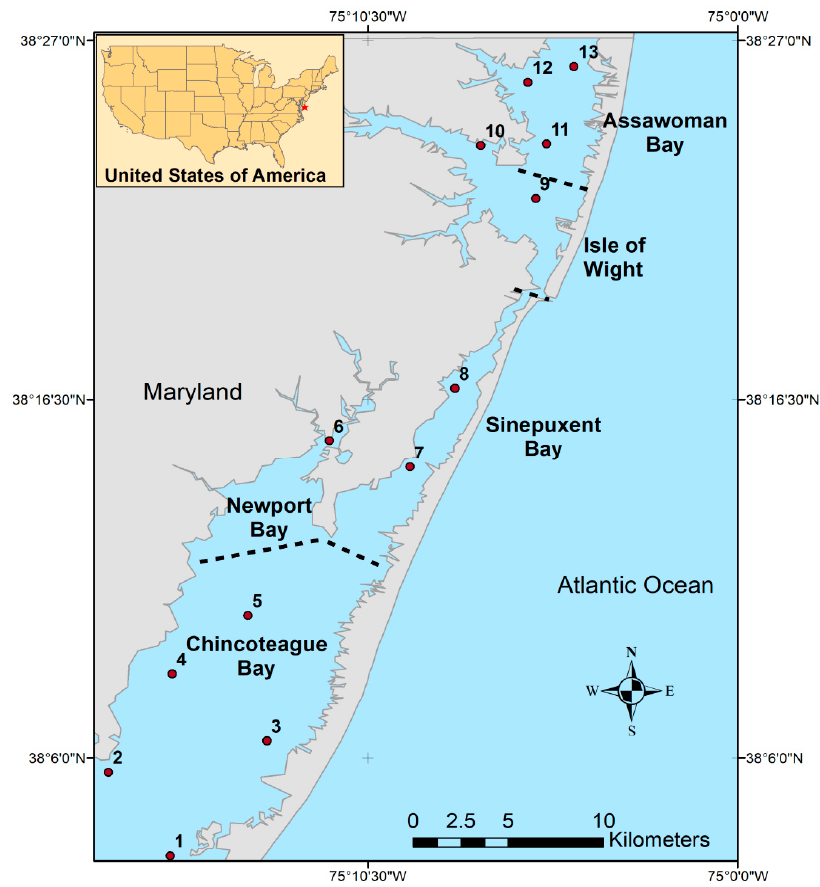
Figure 1. Map of the Maryland Coastal Bays showing sampling sites.